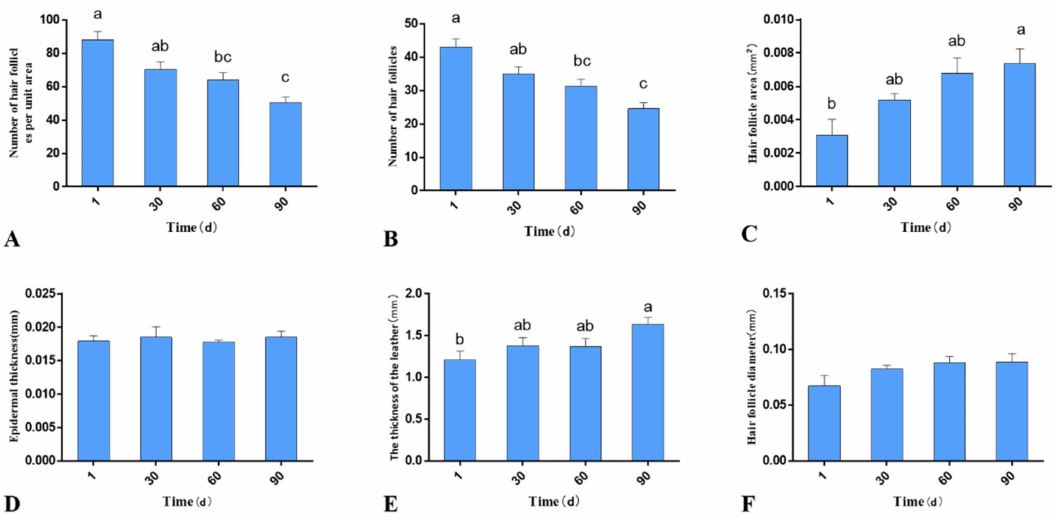
Figure 3. HE staining analysis of skins of Gansu Alpine Merino at various ages. ( A ) The number of hair follicles per unit area at various ages; ( B ) the number of hair follicles at various ages; ( C ) hair follicle area at various ages; ( D ) thickness of the epidermis at various ages; ( E ) thickness of the dermis at various ages; ( F ) diameter of hair follicles at various ages. The data are expressed as the mean ± S.E. Different letters indicate significant differences between different ages ( p <